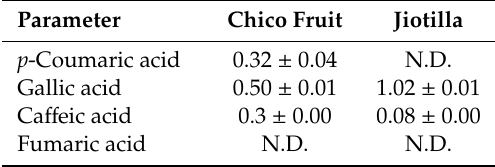
Table 6. Amount of the polyphenolic (mg / 100 g fresh sample). Chico